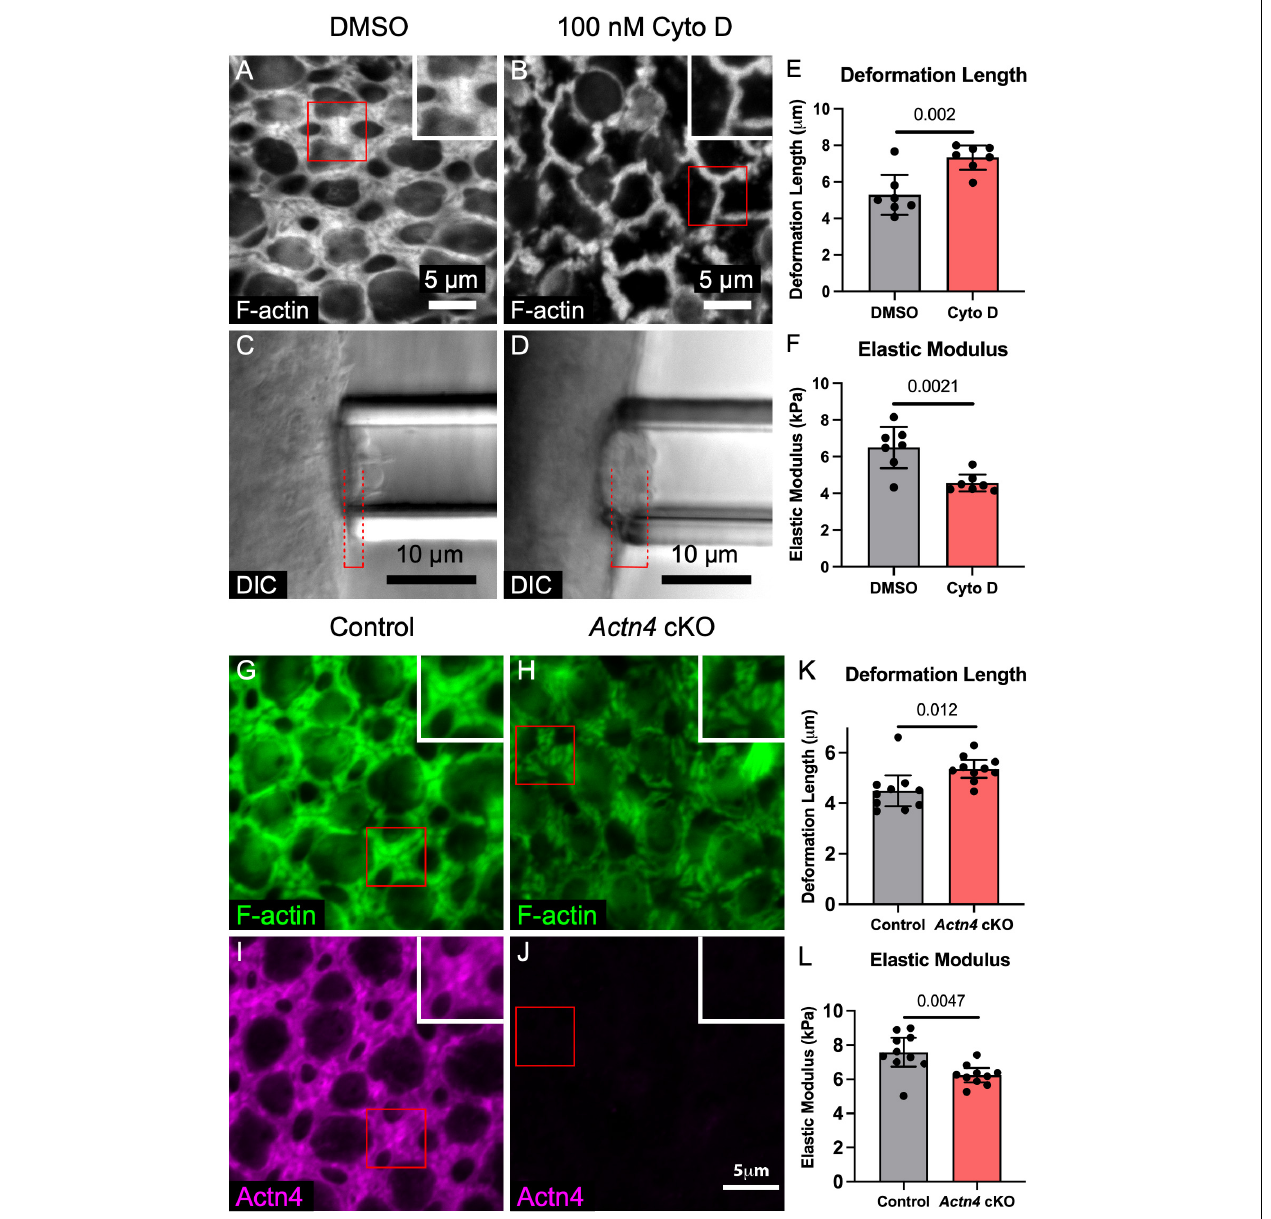
FIGURE 3 | F-actin depolymerization and deletion of the cross-linker Actn4 each disrupt the morphology of the circumferential F-actin bands in SCs of adult mouse utricles and reduce stiffness of the apical surface. (A,B) Representative images of phalloidin-labeled F-actin in utricles from adult mice that were cultured for 24 h in DMSO or 100 nM cytochalasin D (Cyto D), an F-actin depolymerizing agent. Insets depict higher-magnification views of a SC-SC junction. (C,D) Micropipette aspiration of utricles from adult mice that were cultured in DMSO or 100 nM Cyto D for 24 h. Red dashed lines denote the deformation lengths. (E) Blinded quantification revealed that the mean deformation length of utricles cultured in Cyto D was significantly greater than that of DMSO-treated controls. Dots represent an average of at least three measurements from a single utricle. (F) Quantification of elastic modulus revealed a significant difference in stiffness. (G,H) Circumferential F-actin bands were normal in utricles of control Actn4 flox / flox mice, but those in Actn4 cKO mice had disrupted morphology. (I,J) Actn4 immunostaining labeled the F-actin bands in control mice, but the F-actin bands in Actn4 cKO mice had sharply reduced immunoreactivity. (K,L) Quantification of deformation length and elastic modulus from micropipette aspiration of utricles from Actn4 cKO mice and littermate controls. All data are shown as mean ± 95% confidence